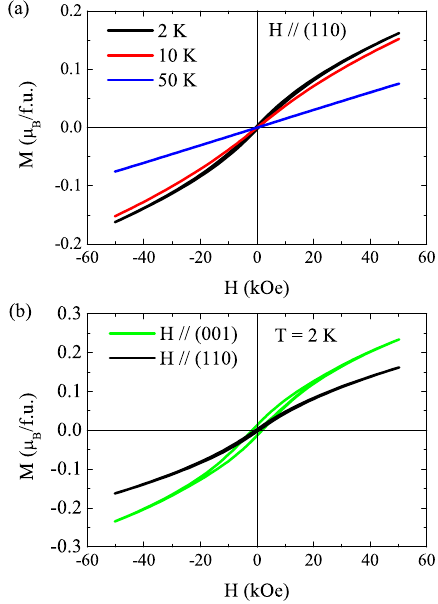
Figure 4. (Color online) ( a ) Isothermal magnetization measurement at different temperatures with the magnetic field along the [1 1 0]-direction; ( b ) Comparison of the magnetization at 2 K for magnetic fields along the [0 0 1]-direction and the[1 1 0]-direction,